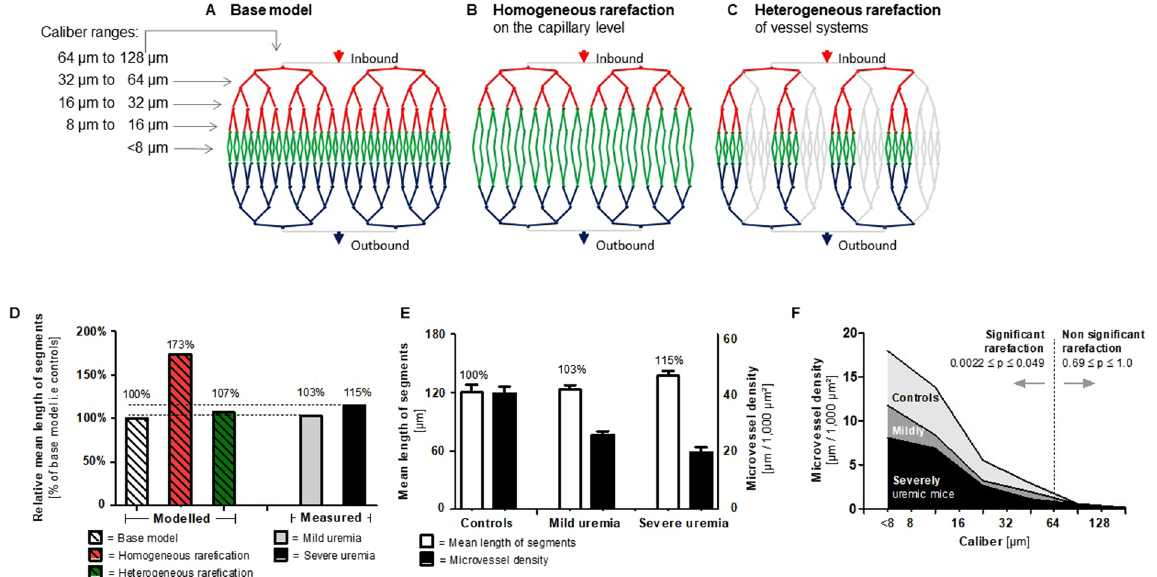
Figure 2. CKD-induced rarefaction is characterized by loss of coherent networks of vessel calibers < 64 µ m. ( A ) Model with two vessel trees, entailing arterial vessels (red), capillaries (green), and venous vessels (blue). A tree consists of nine vessel hierarchy levels with defined caliber ranges ( < 8 µ m, 8 to 16 µ m, 16 to 32 µ m, 32 to 64 µ m, 64 to 128 µ m, and > 128 µ m). ( B ) Model of homogeneous rarefaction by loss of 50% of capillaries. ( C ) Model of heterogeneous rarefaction by loss of four vascular trees. ( D ) In the model of homogeneous rarefaction, the average segment length of the microvessel system (the distance between two adjacent bifurcations) is increased by 73%, and in the heterogeneous rarefaction model by 7%. ( E ) Compared to controls, measured average segment lengths were not significantly increased (only by 3% in mildly uremic, and by 15% in severely uremic mice) despite substantial microvascular rarefaction, indicating loss of coherent microvessel networks. ( F ) Microvessel densities of controls, mildly and severely uremic mice, differentiated by caliber size. Significant rarefaction in the experimental groups affects predominantly microvessels with calibers < 64 µ m. For larger vessels (calibers > 64 µ m) rarefaction is not